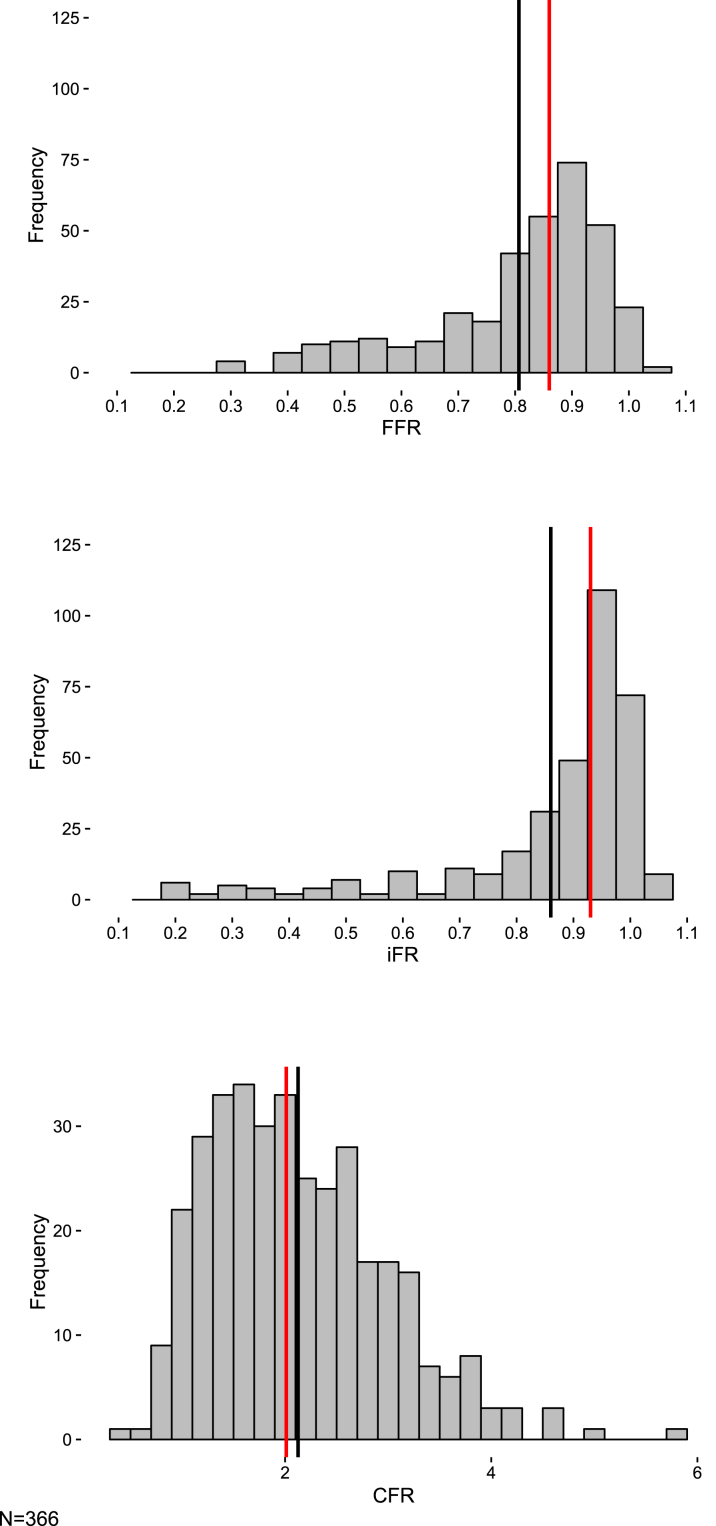
Distribution of FFR, iFR, and CFR Values for Stenosed VesselsFrequency histograms reveal unimodal data distributions of fractional flow reserve (FFR), instantaneous wave-free ratio (iFR), and coronary flow reserve (CFR) values in the stenosed vessel groups. The solid red line indicates the median value. The solid black line indicates the mean value.